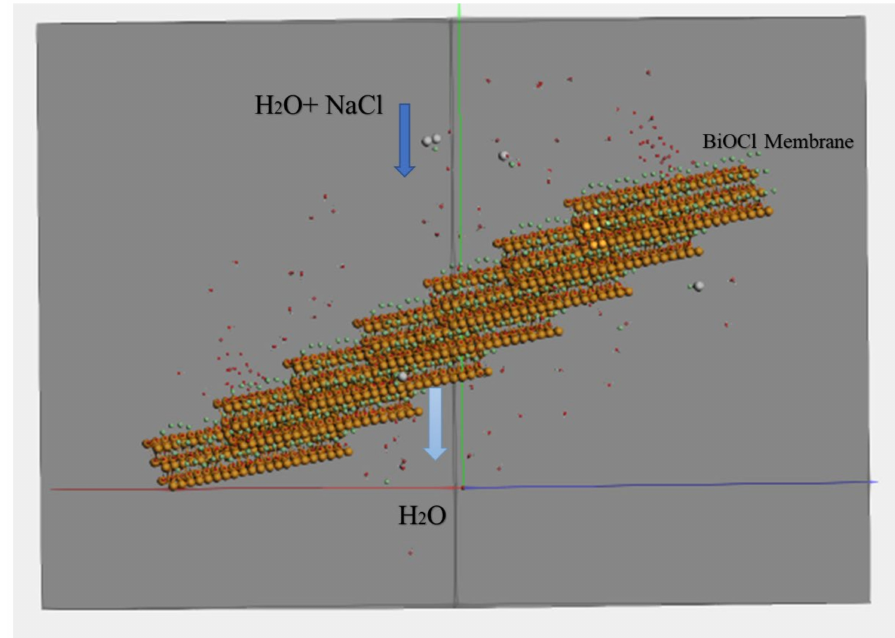
Figure 8. Simulation box consisting of BiOCl membrane molecules in orange, green and red, water molecules (H 2 O atoms) in red and white, NaCl molecules in white and